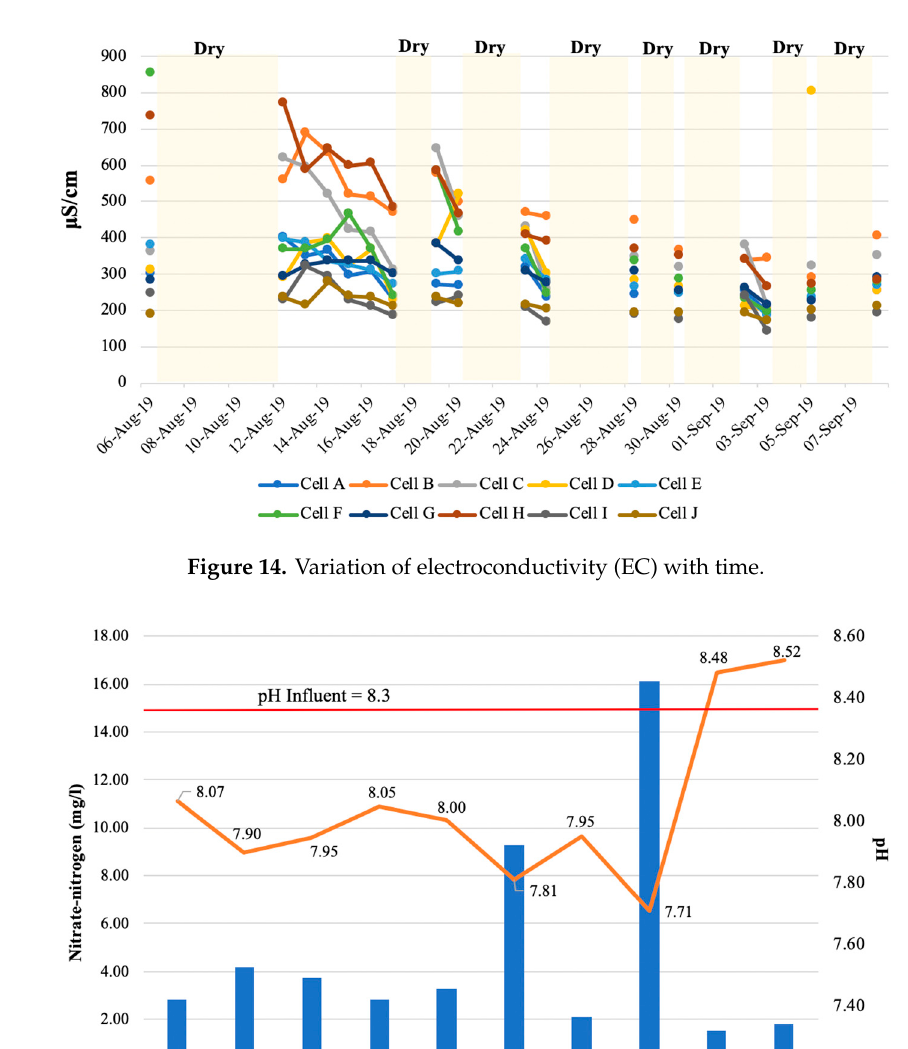
Figure 14. Variation of electroconductivity (EC) with time.